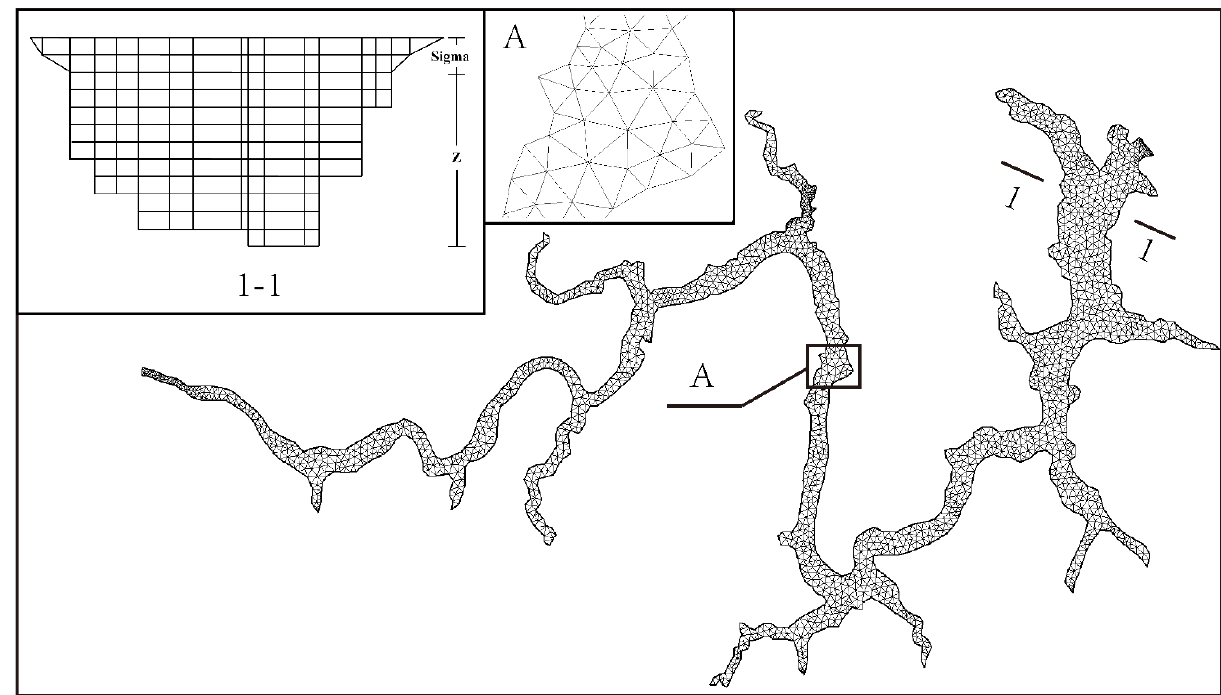
Figure 3. Discretization of 3DNM.